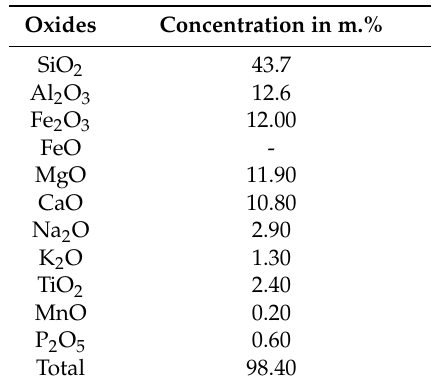
Table 1. Chemical composition of EAC-1 as specified by the suppliers, after Schleppi et al. [8]. Listed oxides are not present in pure form but are incorporated in the